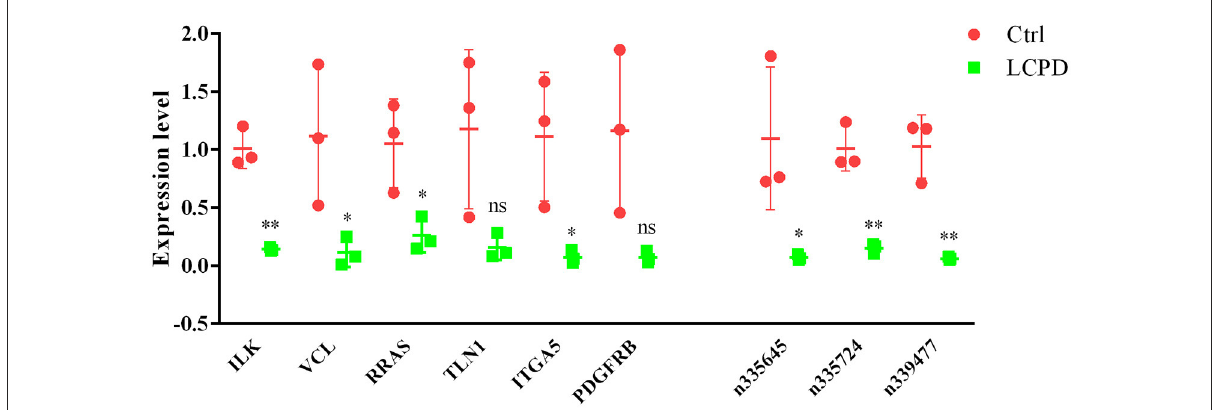
FIGURE9 The expression of 3 selected LncRNAs and 6 mRNAs were validated by RT-qPCR in tissues from LCPD group ( n = 3) and the control group ( n = 3). Data are presented as means ± SD, and relative gene expression level were normalized to the expression of GAPDH (* P < 0.05, ** P < 0.01). ns, no significance.